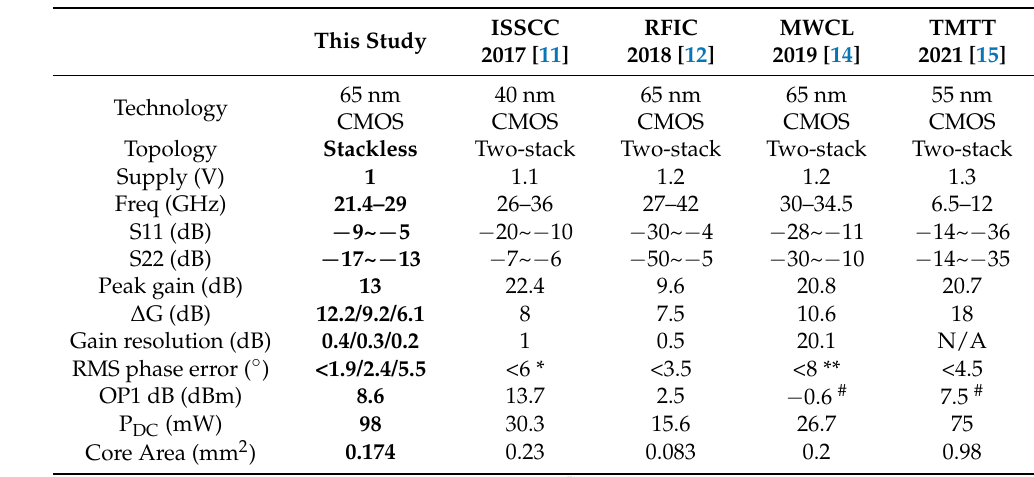
Table 1. Performance summary and comparison of the